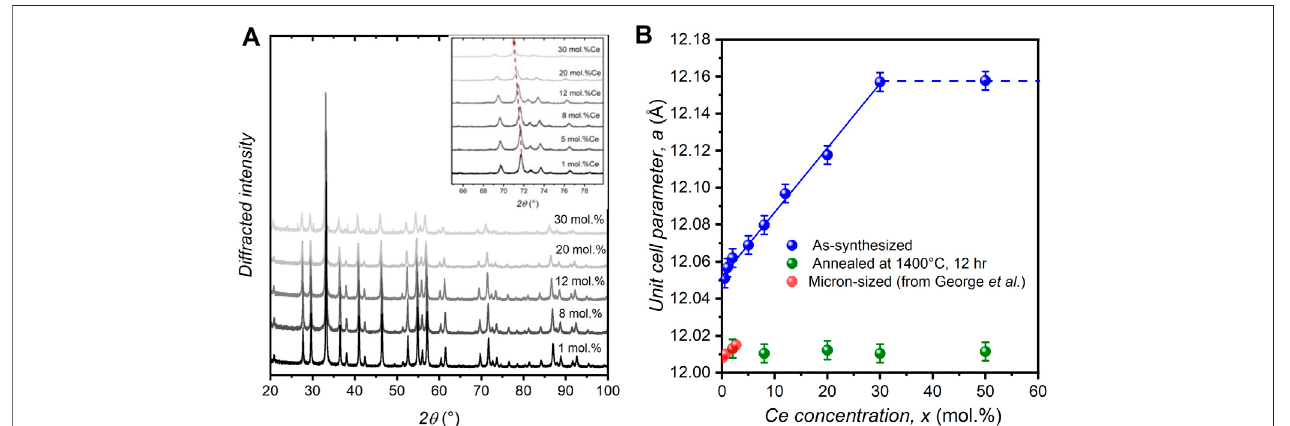
FIGURE 1 | (A) Powder X-ray diffraction patterns of different YAG:Ce: ( α ) x (cid:1) 1 mol.% Ce, ( β ) x (cid:1) 8 mol.% Ce, ( χ ) x (cid:1) 12 mol.% Ce, ( δ ) x (cid:1) 20 mol.% Ce and ( ε ) x (cid:1) 30 mol.% Ce. The inset shows a zoomed view which highlights the peak shift with x. (B) Evolution of the unit cell parameter, a, of as-synthesized (blue) and annealed (green) YAG:Ce nanocrystals as a function of the cerium concentration, x. For comparison, the cell parameter values obtained in micron-sized YAG:Ce are also shown, data from George et al. (2013) (red).